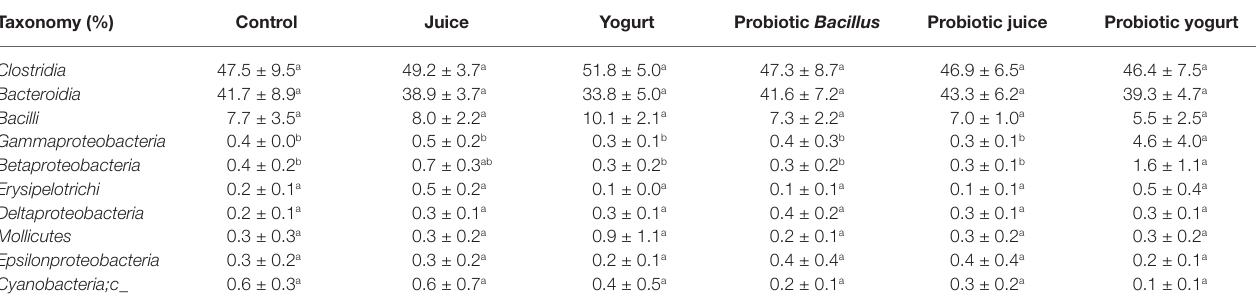
TABLE 4 | Relative abundance of bacterial classes inferred from 16S rRNA gene sequencing analysis. * Taxonomy